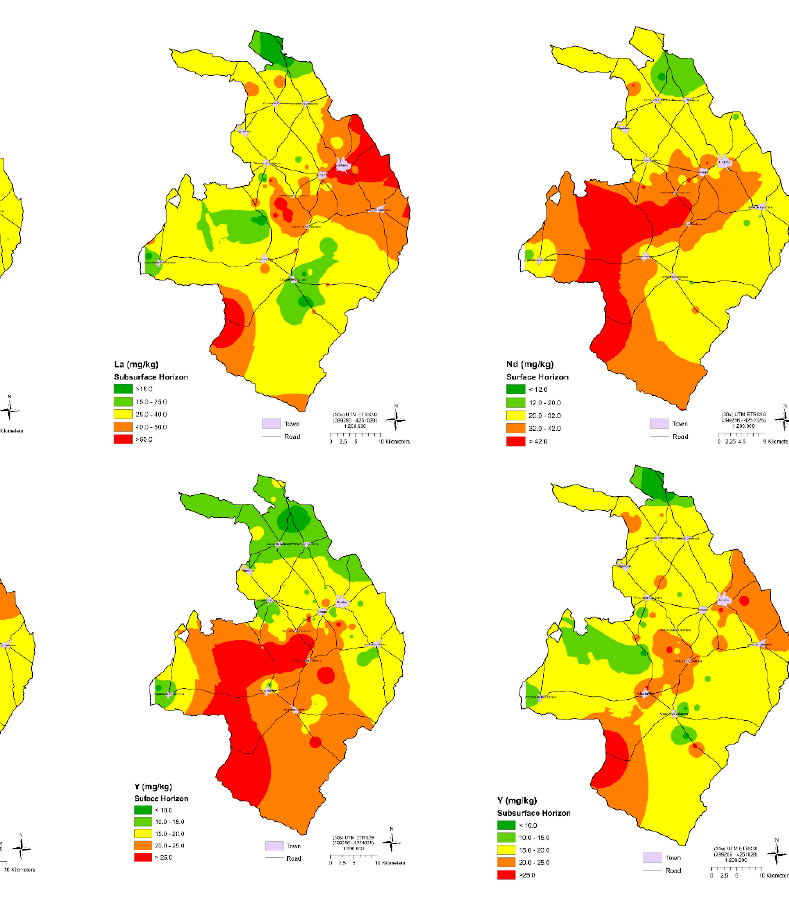
Figure 2. Spatial distribution maps of Ce, Nd, La, Y, and Sc concentrations in surface and subsurface horizons.